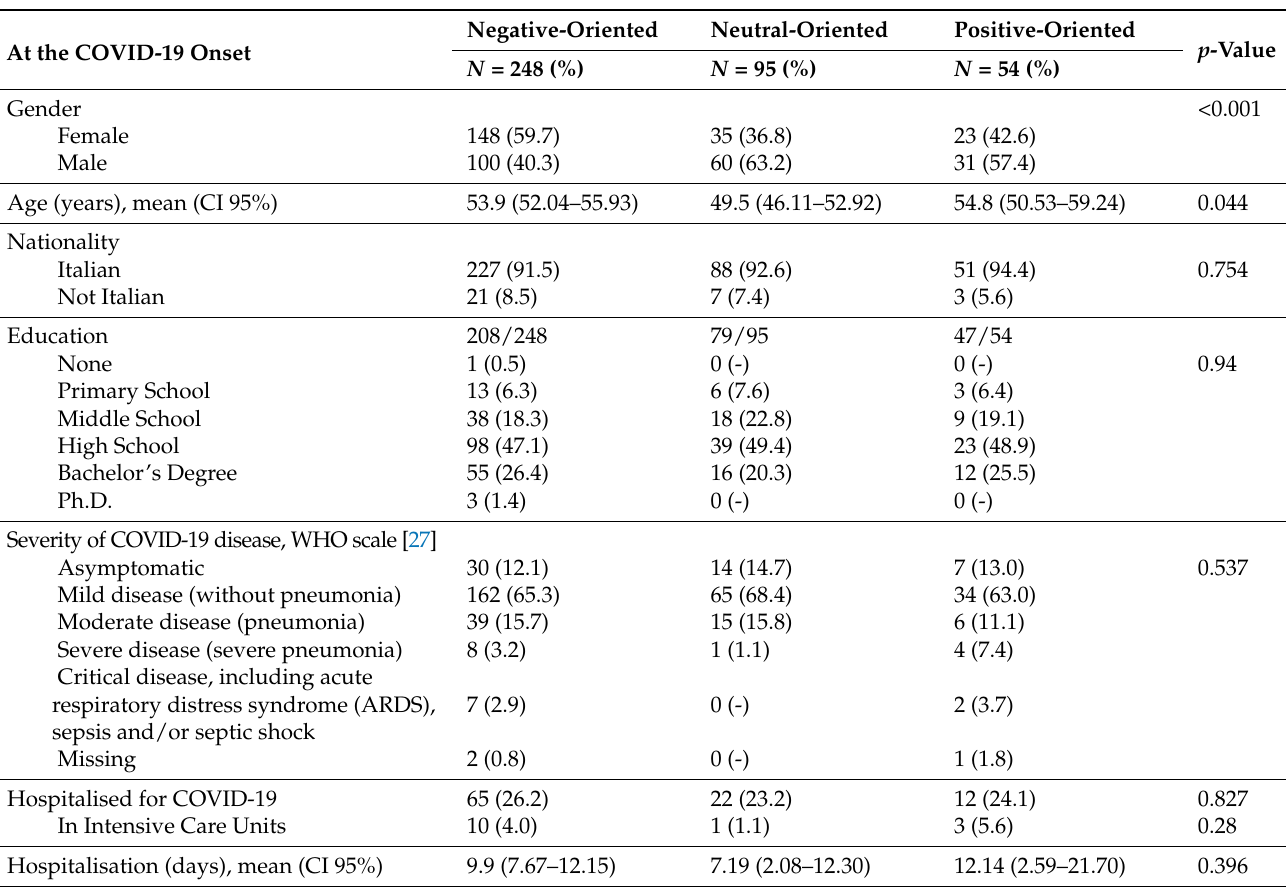
Table 3. Metaphors’ orientations, according to the patients’ characteristics and over